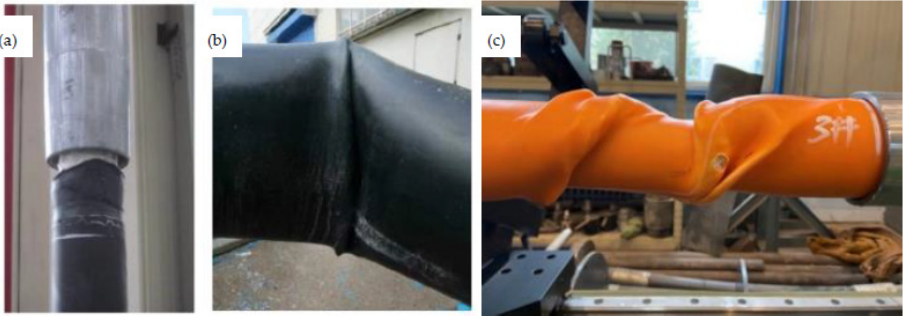
Figure 2. Three typical failure modes of RTP: ( a ) tensile failure; ( b ) buckling failure; ( c ) torsional failure.